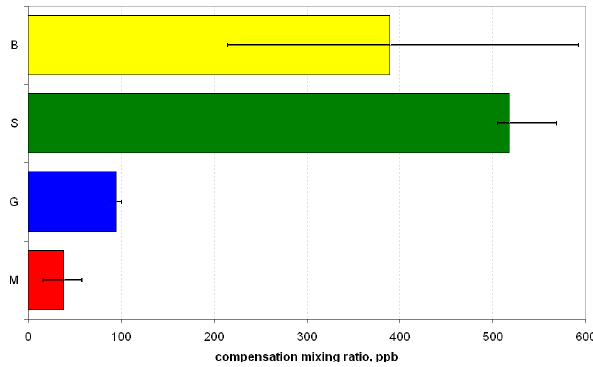
Figure 7. Median NO compensation point mixing ratios, m NO,comp (Eq. 7, section 2.7), for all Fig. 7. Median NO compensation point mixing ratios, m NO , comp soil probes taken under the different understory types of the Weidenbrunnen site at 1±0.1 (Eq. 7, Sect. 2.7), for all soil probes taken under the different un- gravimetric soil moisture and T soil =10°C. The bars indicate the range between the 25% and derstory types of the Weidenbrunnen site at 1 ± 0.1 gravimetric soil 75% percentile of the data (n=10, for each understory type data set). moisture and T soil =10 ◦ C. The bars indicate the range between the 25% and 75% percentile of the data ( n =10, for each understory type data set). Figure 8. Net potential NO flux (all expressed in terms of mass of nitrogen) at 10°C and 20°C